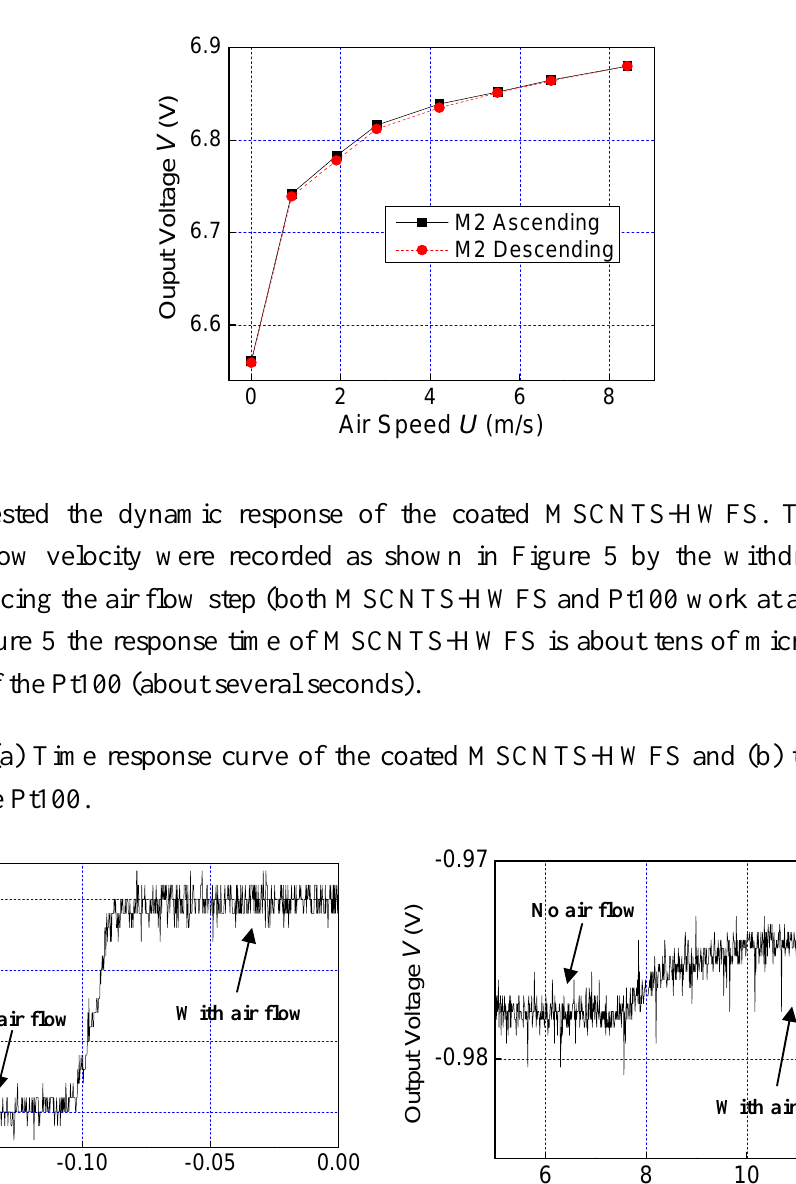
Figure 4. Response curves of the covered MSCNTS-HWFS.